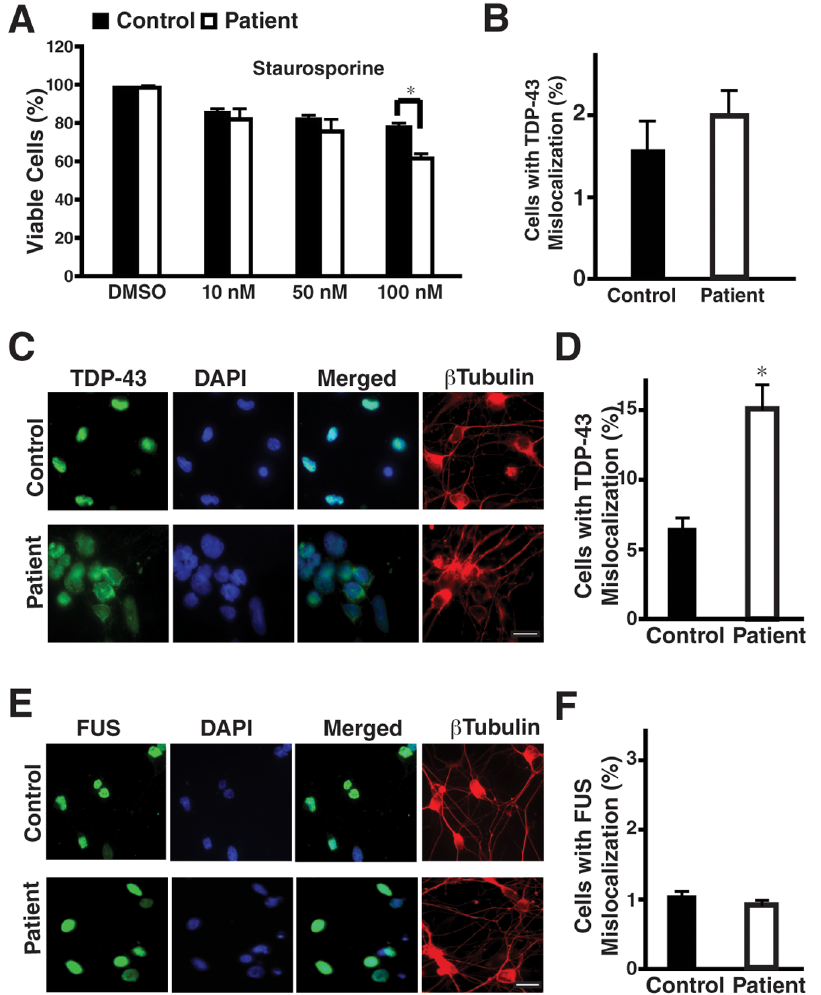
Figure 4. Patient neurons with the TDP-43 mutation are more susceptible to staurosporine and display increased TDP-43 mislocalization under stress. (A) Viability of control and patient neurons after exposure to10–100 nM staurosporine (STS) for 24 hours. More patient neurons die after treatment with 100 nM STS. Values are mean 6 SEM. *: p , 0.05 (Student’s t-test). (B) The percentages of TUJ1 + control and patient neurons with mislocalized TDP43 without any stressor treatment. In Panels A and B, iPSC lines 37L20, 37L25, 36L10 and 36L11 were used. (C, D) Representative images of TDP-43 and TUJ1 staining in control and patient neurons differentiated from iPSC lines 37L20 and 36L10 after treatment with 100 nM staurosporine for 24 hours (C) and the percentage of TUJ1 + control and patient neurons showing mislocalized TDP-43 (D). After STS treatment, more patient neurons show TDP-43 cytoplasmic mislocalization. Some cells are non-neuronal cells, for instance, some cells with large nuclei are not labeled by MAP2. Values are mean 6 SEM. *: p , 0.05 (Student’s t-test). (E, F) Representative images of FUS and TUJ1 staining in control and patient neurons differentiated from 37L20 and 36L11 after treatment with 100 nM staurosporine for 24 hours (E) and the percentage of TUJ1 + control and patient neurons differentiated from 37L20, 37L25, 36L10 and 36L11 showing mislocalized FUS (F). FUS localization is not affected by